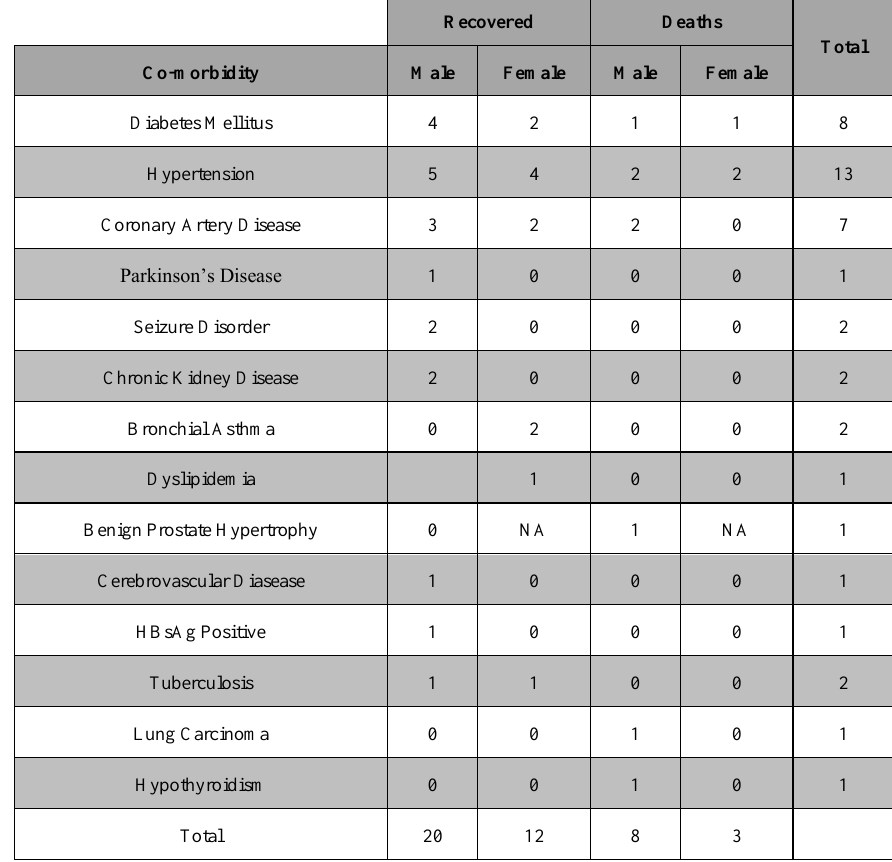
Table 11. Different co-morbidities in various study